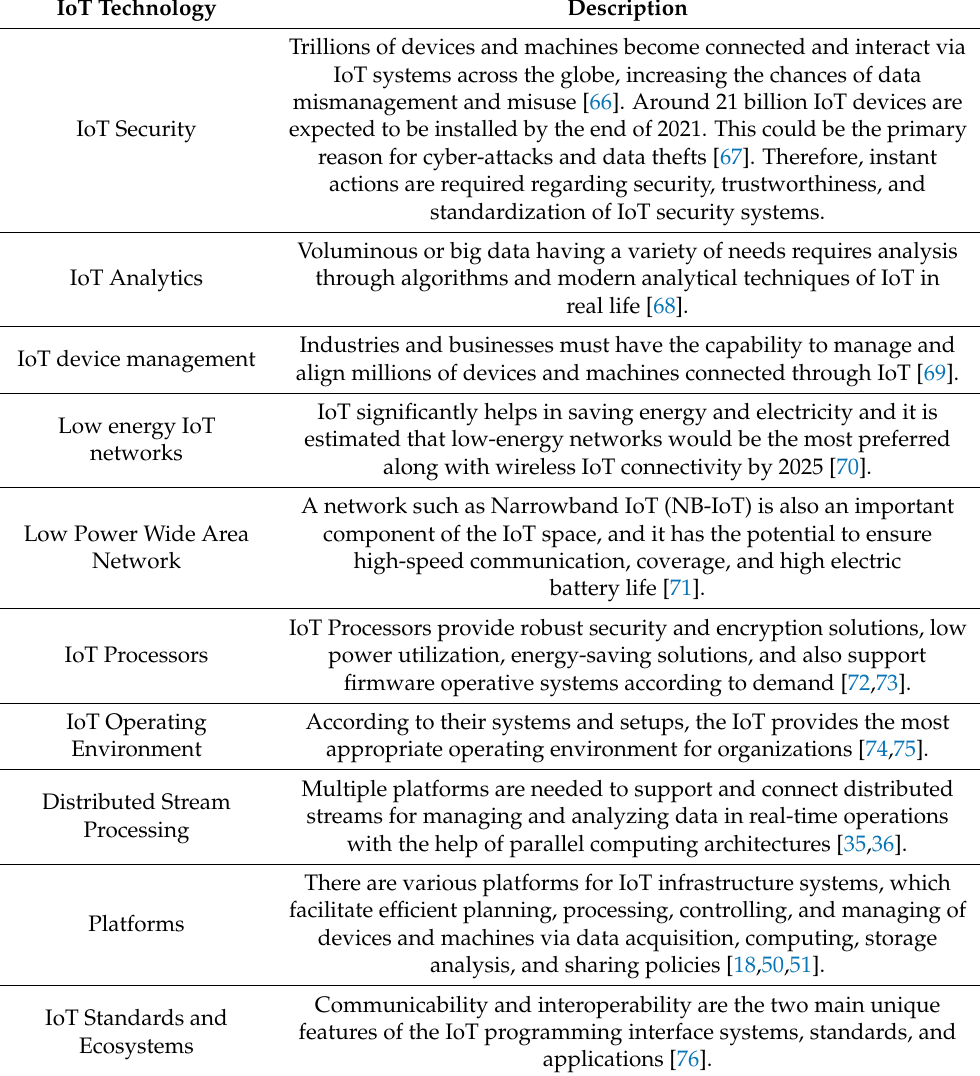
Table 1. Technologies of the Internet of